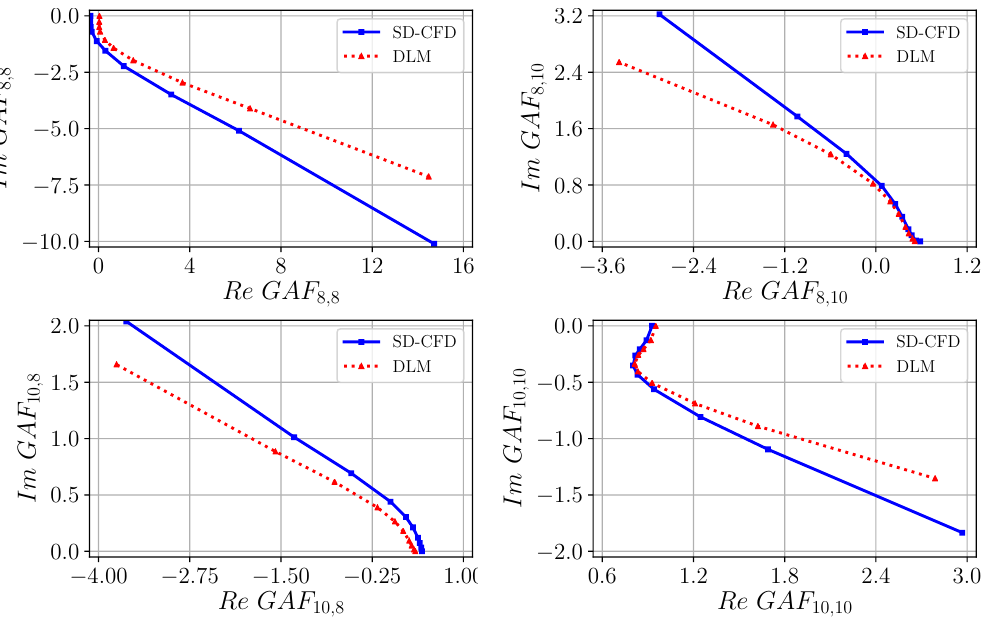
Figure 22. Comparison of SD-CFD and DLM with regard to resulting GAF entries of the dominant flutter modes at k red = [ 0.0; 0.1; 0.2; 0.3; 0.5; 0.7; 1.0; 1.5; 2.0; 3.0 ] .